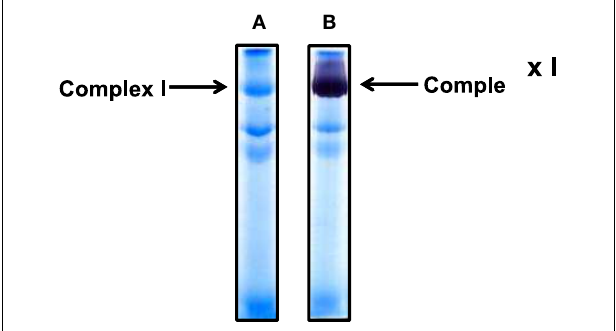
FIGURE 1 | Non-gradient blue native gel electrophoresis of cardiac mitochondria isolated from rat heart. (A) Gel image after electrophoresis without further CBB staining; (B) complex I activity staining by NADH and NBT. An 8% resolving gel was performed.